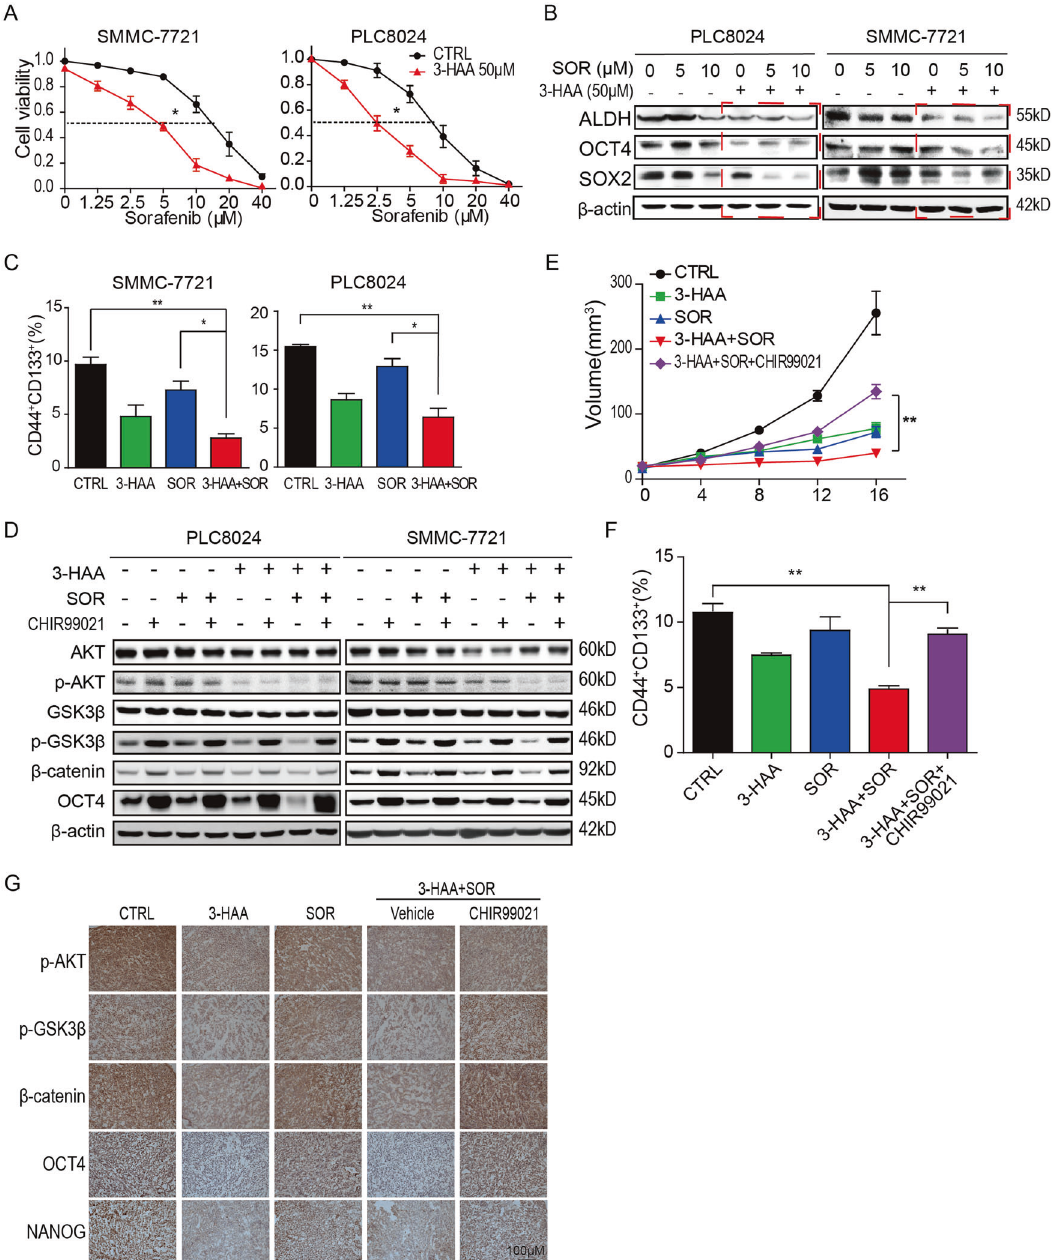
Fig. 5 The 3-HAA increases the sensitivity of HCC cells to sorafenib by suppressing stemness. A The cell viability of 3-HAA-treated SMMC- 7721 and PLC8024 cells was analyzed by CCK8 assay. Cells were treated with sorafenib at the indicated dose with or without 100 μ M 3-HAA for 4 days. * P < 0.05. B The combination of 3-HAA and sorafenib dramatically inhibited ALDH, SOX2, and OCT4 expression in SMMC-7721 and PLC8024 cells. Cells were treated with 100 μ M of 3-HAA and sorafenib at the indicated dose for 24 h. C The combination of sorafenib and 3-HAA signi fi cantly reduced the proportion of CD133 + CD44 + tumor cells than either 3-HAA alone or sorafenib alone in SMMC-7721 and PLC8024 cells. Cells were treated with 100 μ M 3-HAA and 5 μ M sorafenib for 24 h. * P < 0.05, ** P < 0.01. D CHIR99021 recovered the AKT/GSK3 β / β -catenin signaling and the expression of stemness markers, inhibited by the combination treatment. Cells were treated with 100 μ M 3-HAA, 5 μ M sorafenib, and/or 5 μ M CHIR99021 for 24 h. E CHIR99021 recovered the combination-suppressed tumor growth of SMMC-7721 xenografts. 3-HAA and sorafenib were separately administrated by intraperitoneal injection for 16 days at the dose of 100 and 10 mg/kg day, respectively. CHIR99021 was administered orally at 40 mg/kg day, fi ve mice were recruited in each group. The tumor volumes are presented as mean ± SD. ** P < 0.01. F CHIR99021 increased the ratio of CD44 + CD133 + subpopulation in SMMC-7721 xenografts. Tumor cells were analyzed by fl ow cytometry using anti-CD133-PE and anti-CD44-APC. ** P < 0.01. G CHIR99021 increased the combination-inhibited AKT/Wnt/ β